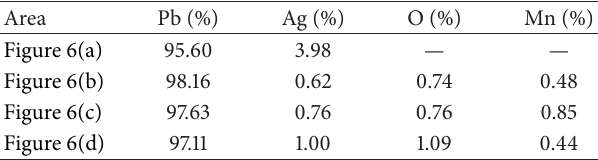
of electrowinning process, obtained at different areas (see Figure